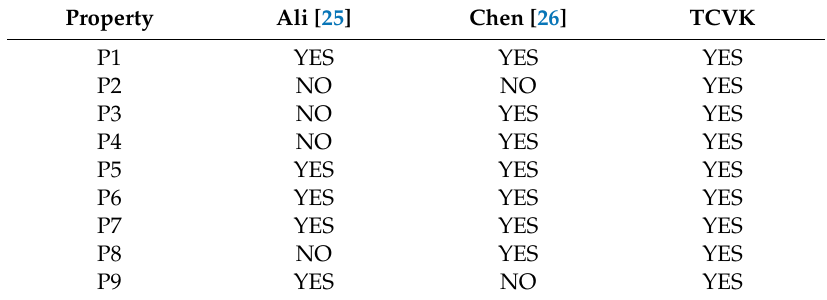
Table 1. Functionality comparisons. Two-phase pre-checkup and subsequent validation key agreement authentication mechanism (TCVK).